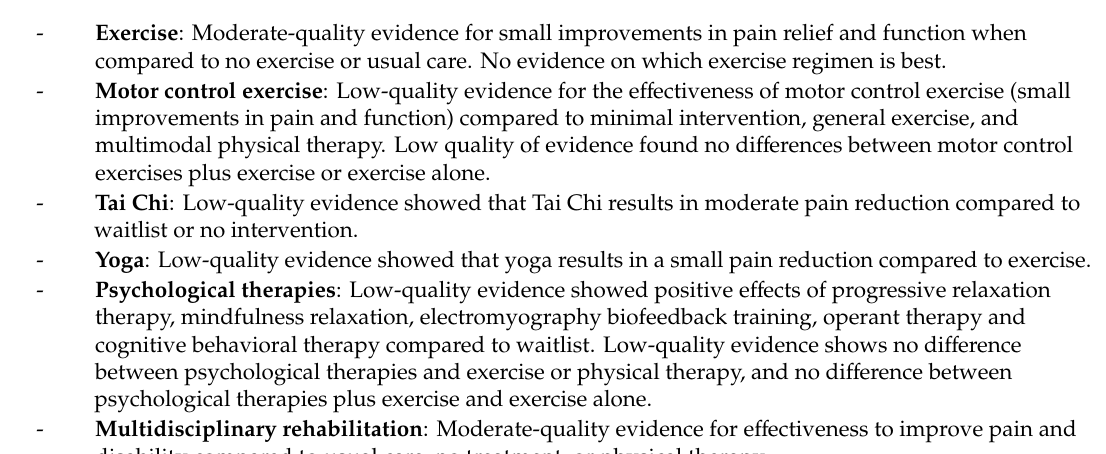
Guideline Recommendation for CLBP - Exercise : Moderate-quality evidence for small improvements in pain relief and function when compared to no exercise or usual care. No evidence on which exercise regimen is best. - Motor control exercise : Low-quality evidence for the e ff ectiveness of motor control exercise (small improvements in pain and function) compared to minimal intervention, general exercise, and multimodal physical therapy. Low quality of evidence found no di ff erences between motor control exercises plus exercise or exercise alone. Tai Chi : Low-quality evidence showed that Tai Chi results in moderate pain reduction compared to waitlist or no intervention. Psychological therapies : Low-quality evidence showed positive e ff ects of progressive relaxation therapy, mindfulness relaxation, electromyography biofeedback training, operant therapy and cognitive behavioral therapy compared to waitlist. Low-quality evidence shows no di ff erence between psychological therapies and exercise or physical therapy, and no di ff erence between psychological therapies plus exercise and exercise alone. Multidisciplinary rehabilitation : Moderate-quality evidence for e ff ectiveness to improve pain and disability compared to usual care, no treatment, or physical